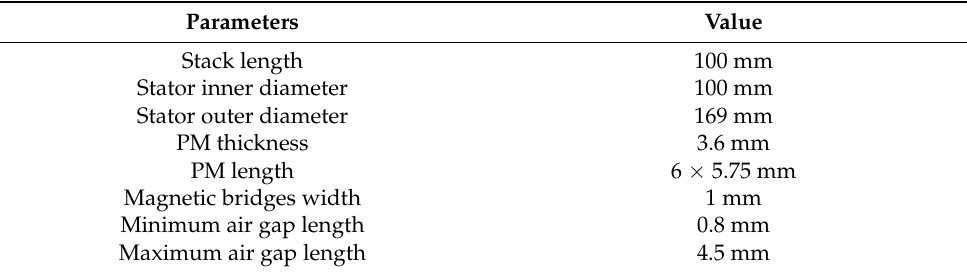
Table 3. The initial main dimensions of the RSPMSM.